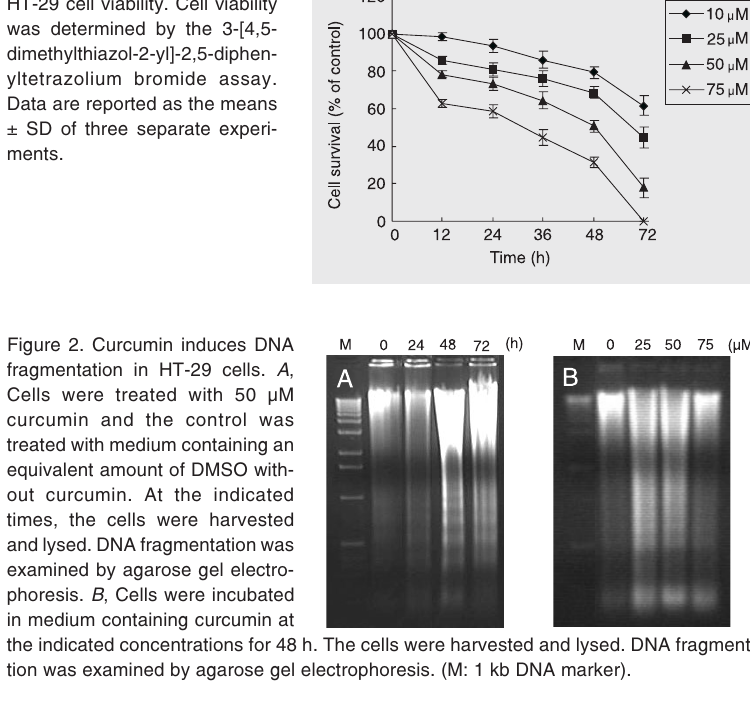
Figure 1. Effect of curcumin on HT-29 cell viability. Cell viability was determined by the 3-[4,5- dimethylthiazol-2-yl]-2,5-diphen- yltetrazolium bromide assay. Data are reported as the means ± SD of three separate experi- ments.